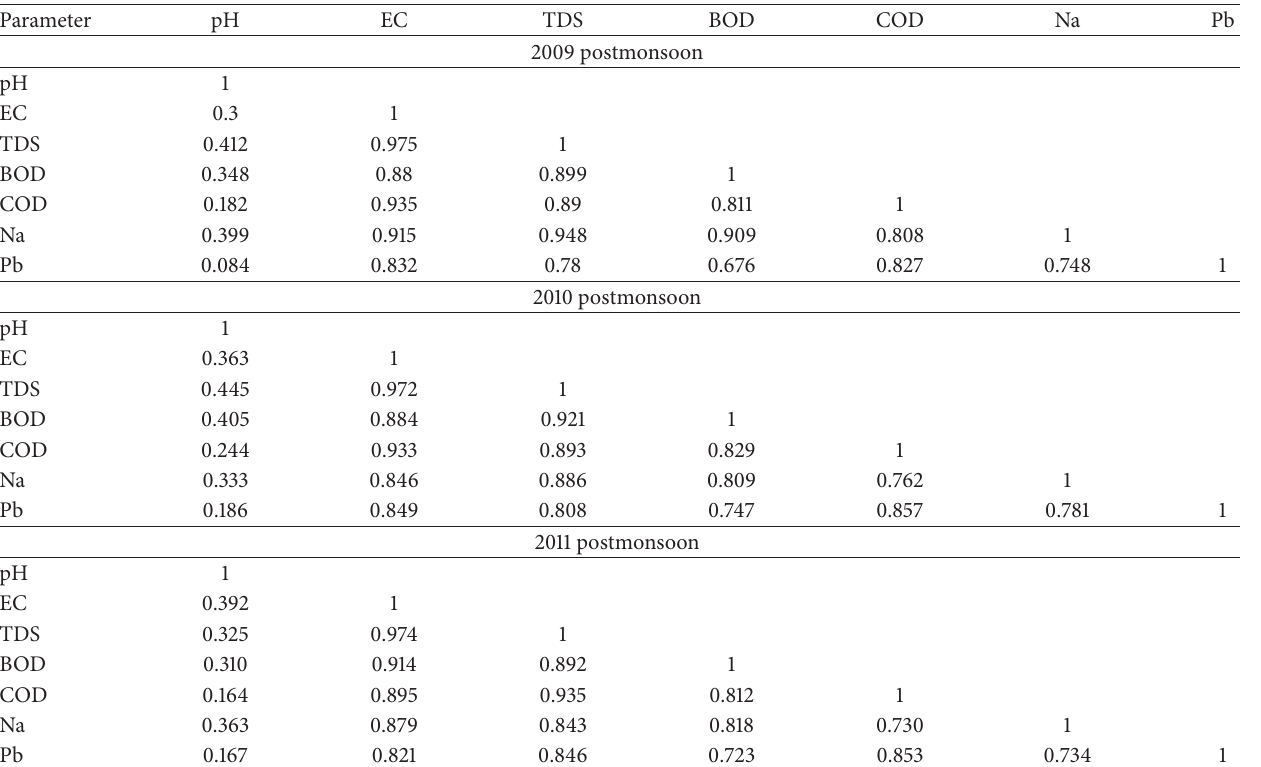
Table 8: Correlation coefficient ( 𝑟 ) for different water quality